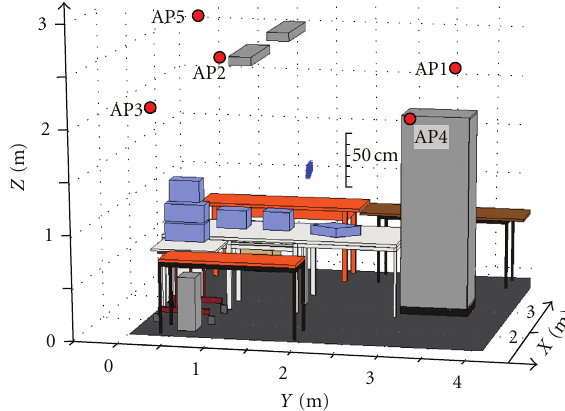
Figure 15: The localization solutions (cloud of blue points in the middle) are plotted into the scenario. The TDoA data comes from the